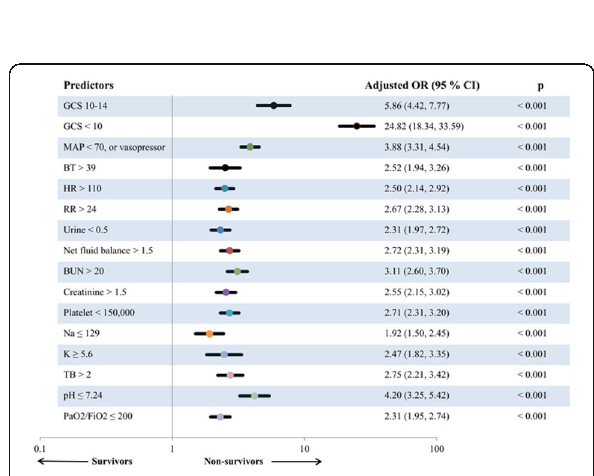
Fig. 2 (abstract P5). Forest plot in log-10 scale of odds ratio (adjusted for age, gender, body mass index and co-morbidities; including hypertension, diabetes, coronary artery disease, cerebrovascular disease, malignancy, chronic kidney disease) in prediction of non-survivor